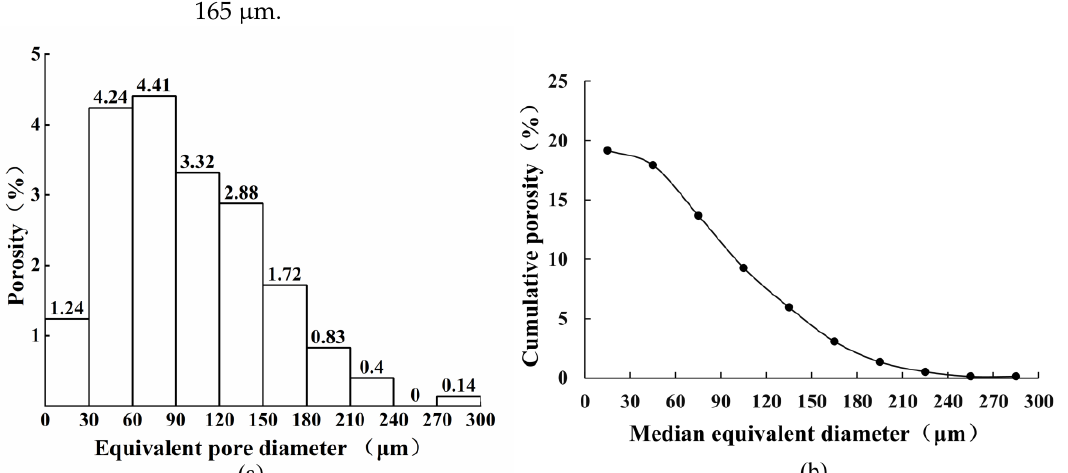
Figure 6. ( a ) Porosity distribution over an equivalent pore diameter range of 300 µ m; ( b ) cumulative porosity plotted against median equivalent diameter.